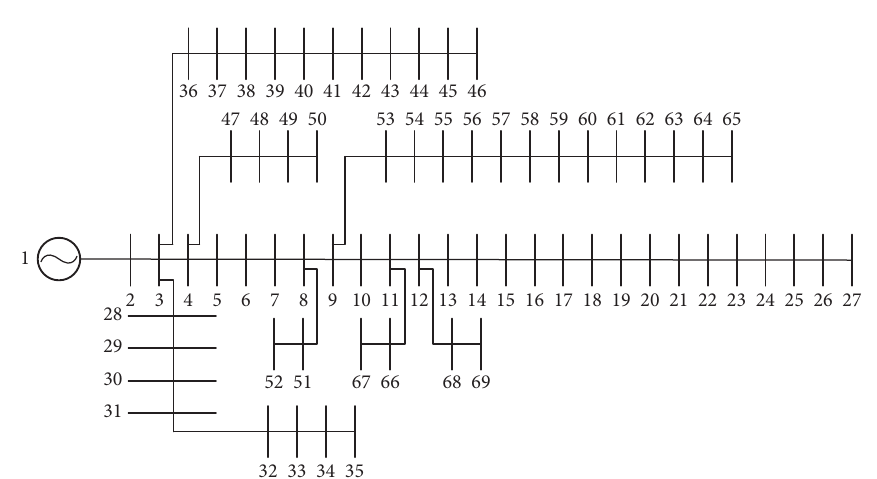
Figure 3: IEEE 69-bus distribution